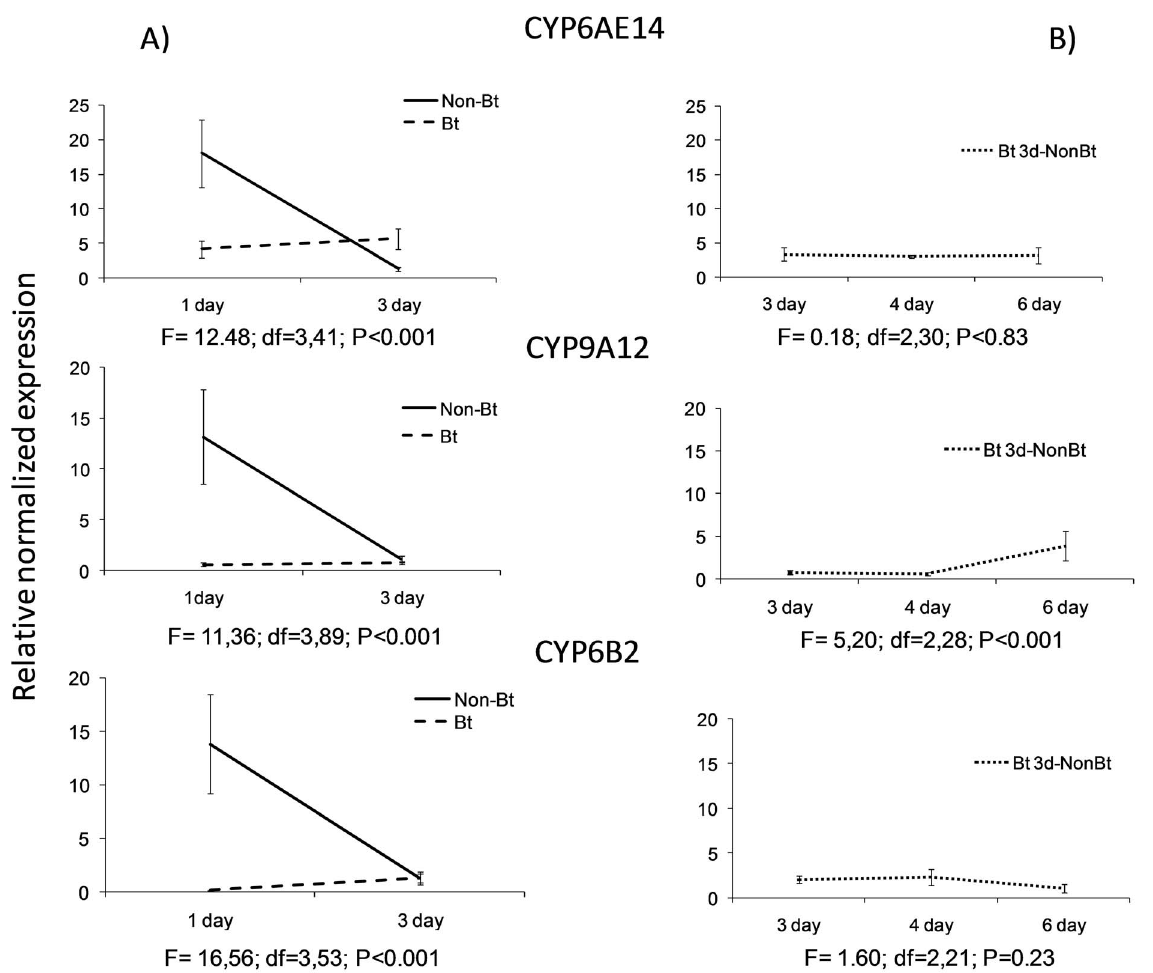
Figure 5. Relative normalized expression of the CYP6AE14, CYP9A12 and CYP6B2 genes in L 6 larvae of Helicoverpaarmigera fed A) for one (1 day) or three (3day) days on a the non-Bt or Bt diet and B) for three days on the Bt diet (day 3) and then one (4 day) or three (6 day) days on the non-Bt diet (Bt 3d-non Bt). Values represent the mean of at least three replicates 6 SE.